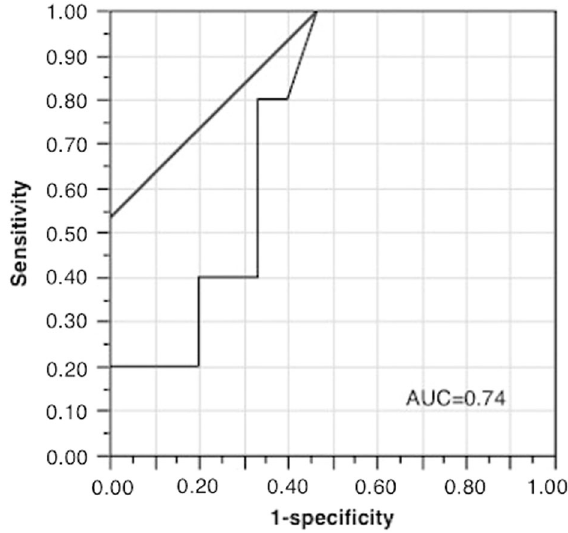
Fig. 5 Receiver operating characteristic (ROC) curve for pCR to determine the CEP increase cut-off. The x-axis indicates 1-speci fi city, and the y-axis indicates sensitivity. The area under the ROC curve was 0.74. It gave the CEP increase cut-off as 15 cells (AUC = 0.74)